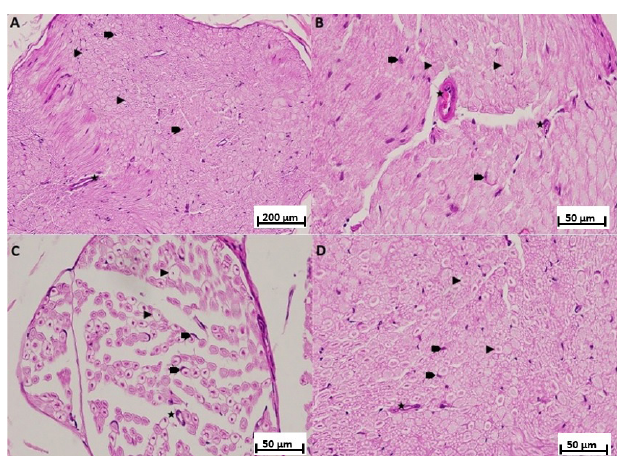
FIGURE 7 - Hematoxylin-eosin staining of the sciatic nerve tissue. A healthy nerve tissue in CG; ►: myelinated axons, : Schwann cells, blood vessels, ×200. B – C Damaged nerve tissue in the ACR group; ►: degenerated myelinated axons, : hypertrophic and hyperplasic Schwann cells, : congested blood vessels, ×400. D AAC appearance is similar to normal nerve tissue: ►: myelinated axons, : Schwann cells, blood vessels, ×400.